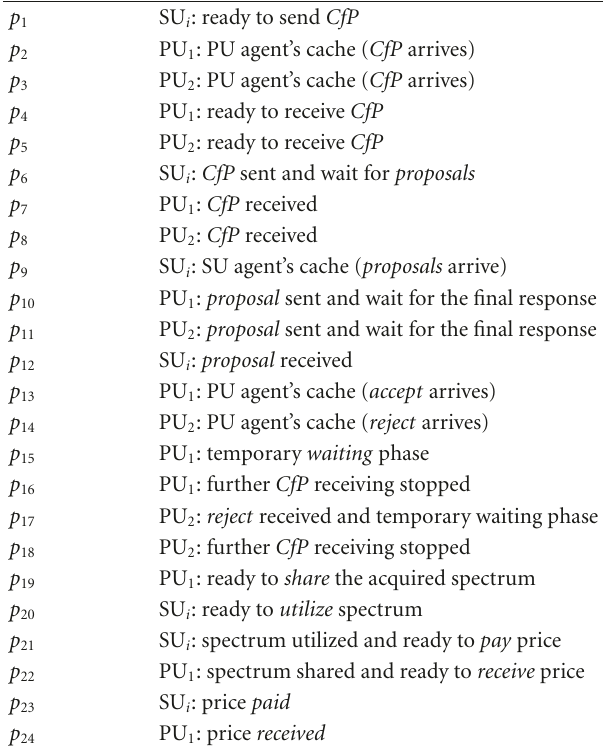
Table 1: Spectrum sharing states.